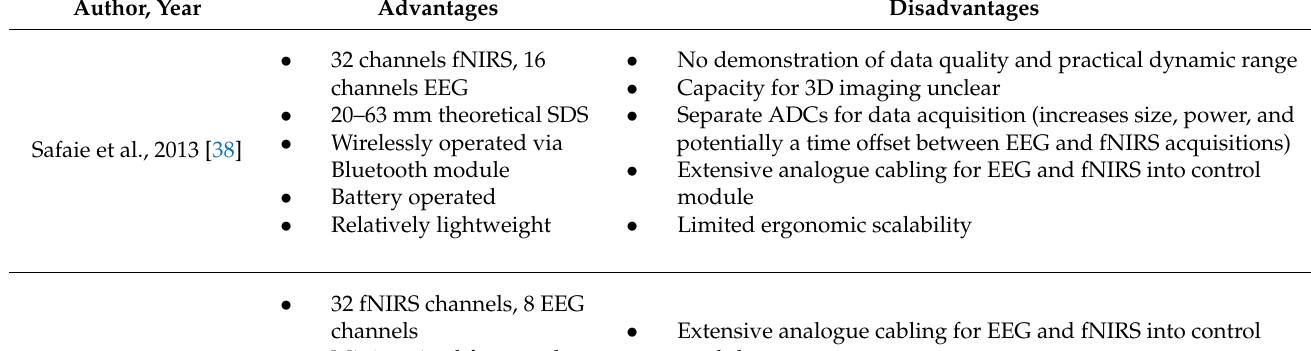
Table 2. Summary of the advantages and disadvantages of the integrated EEG–fNIRS systems described in this